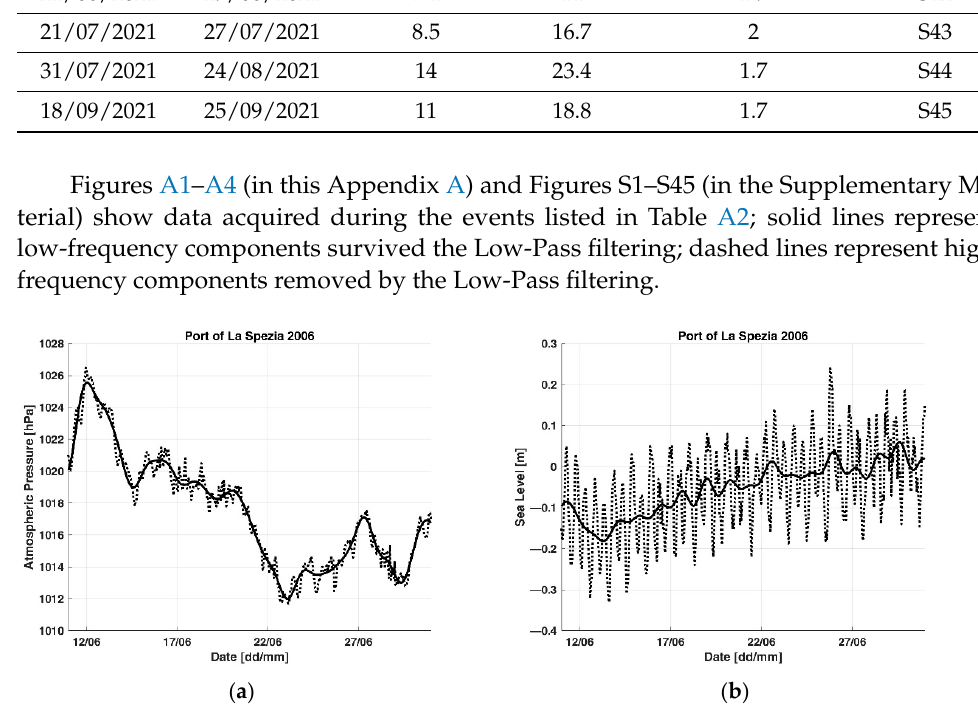
Figure A1. Measurements carried out between 11 June and 01 July 2006 inside the port of La Spezia: ( a ) atmospheric pressure; ( b ) sea level ( ∆ p = 13.5 hPa, ∆ h = 24 cm, J ph = 1.8 cm ∗ hPa − 1 ).